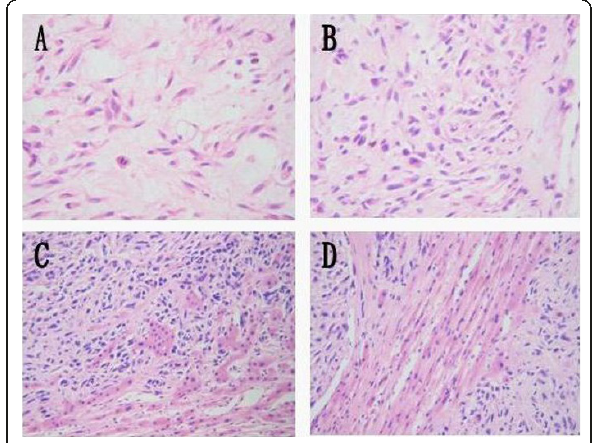
Figure 5 Microscopic appearance . (A) The mitosis of the nucleus. (B) Heteromorphism of the tumor. (C) and (D) Juncture of the